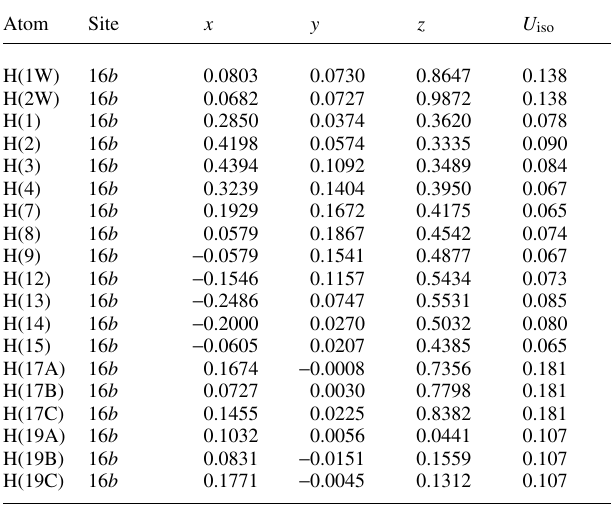
Table 2. Atomic coordinates and displacement parameters (in Å 2 )